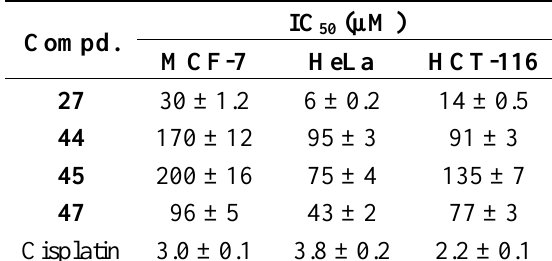
Table 5. IC 50 values for compounds 27 , 44 , 45 and 47